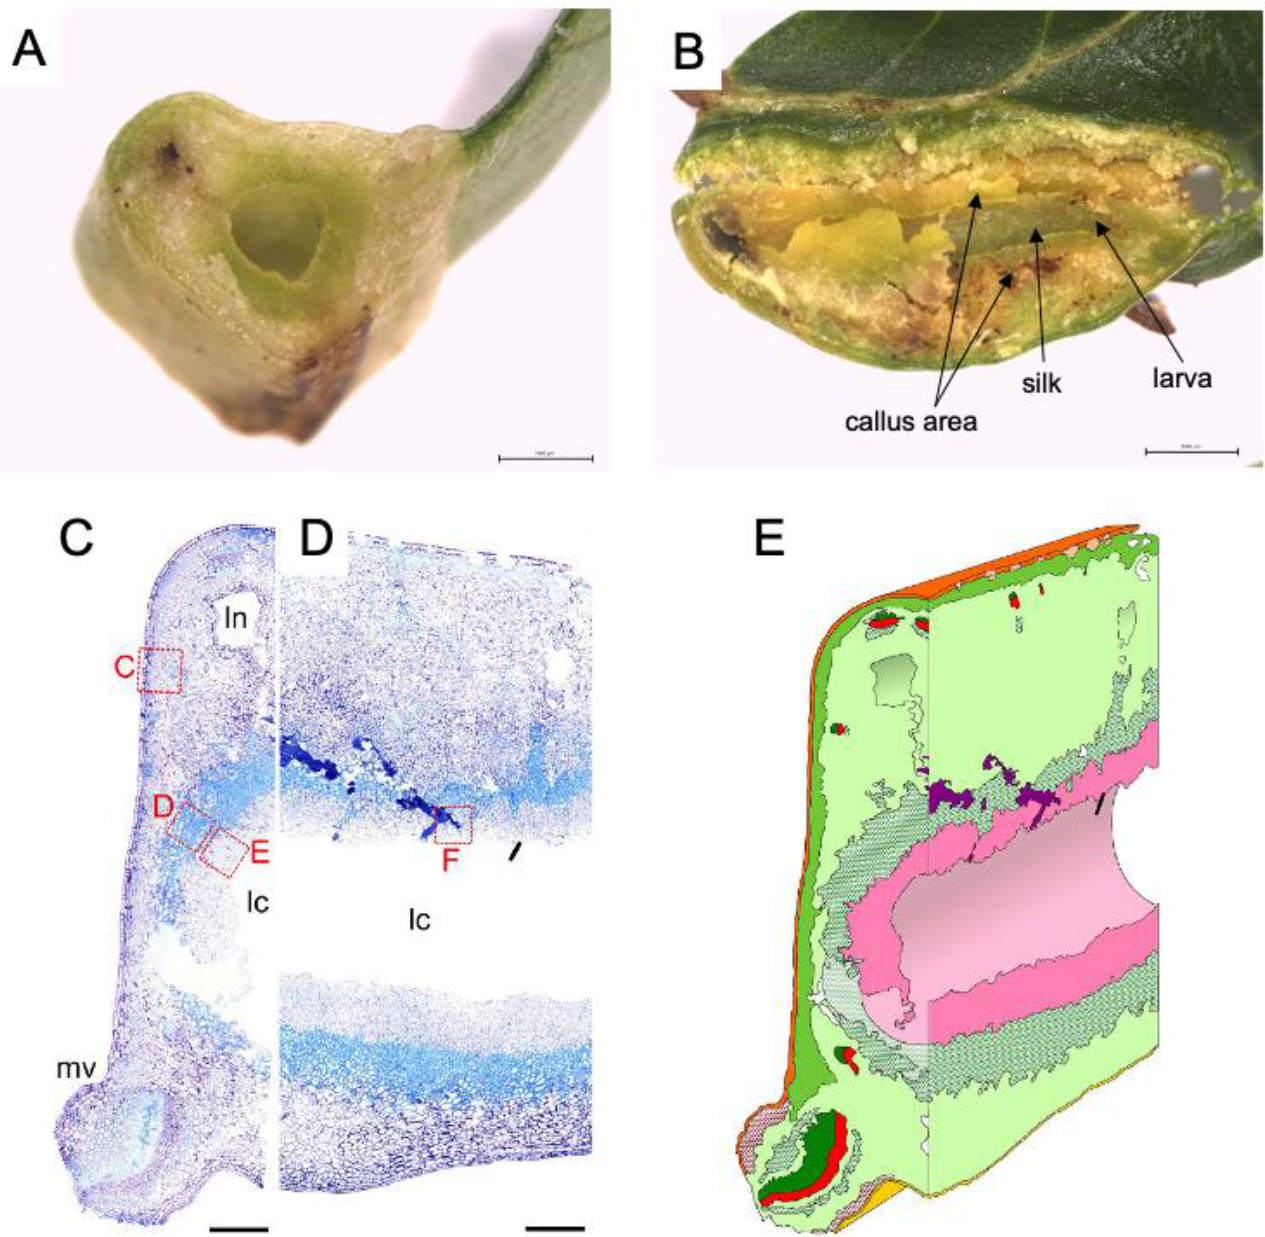
Figure 2. Inside of leaf gall on Glochidion obovatum . ( A ) Transverse section. ( B ) Sagittal section showing callus-like cells, silk covering the chamber wall, and larva inside the chamber. ( C , D ) Histological transverse ( C ) and sagittal ( D ) sections. Ln: lacuna, lc: larva chamber, mv: midvein. ( E ) 3D representation of gall inside based on histology sections. Dark green: xylem, red: phloem, pink: nutritive tissue, green cross: sclerenchyma, red cross: collenchyma, purple: frass. Bars: A, B, 1 mm; C, D, 0.5 mm. Panels are cited from